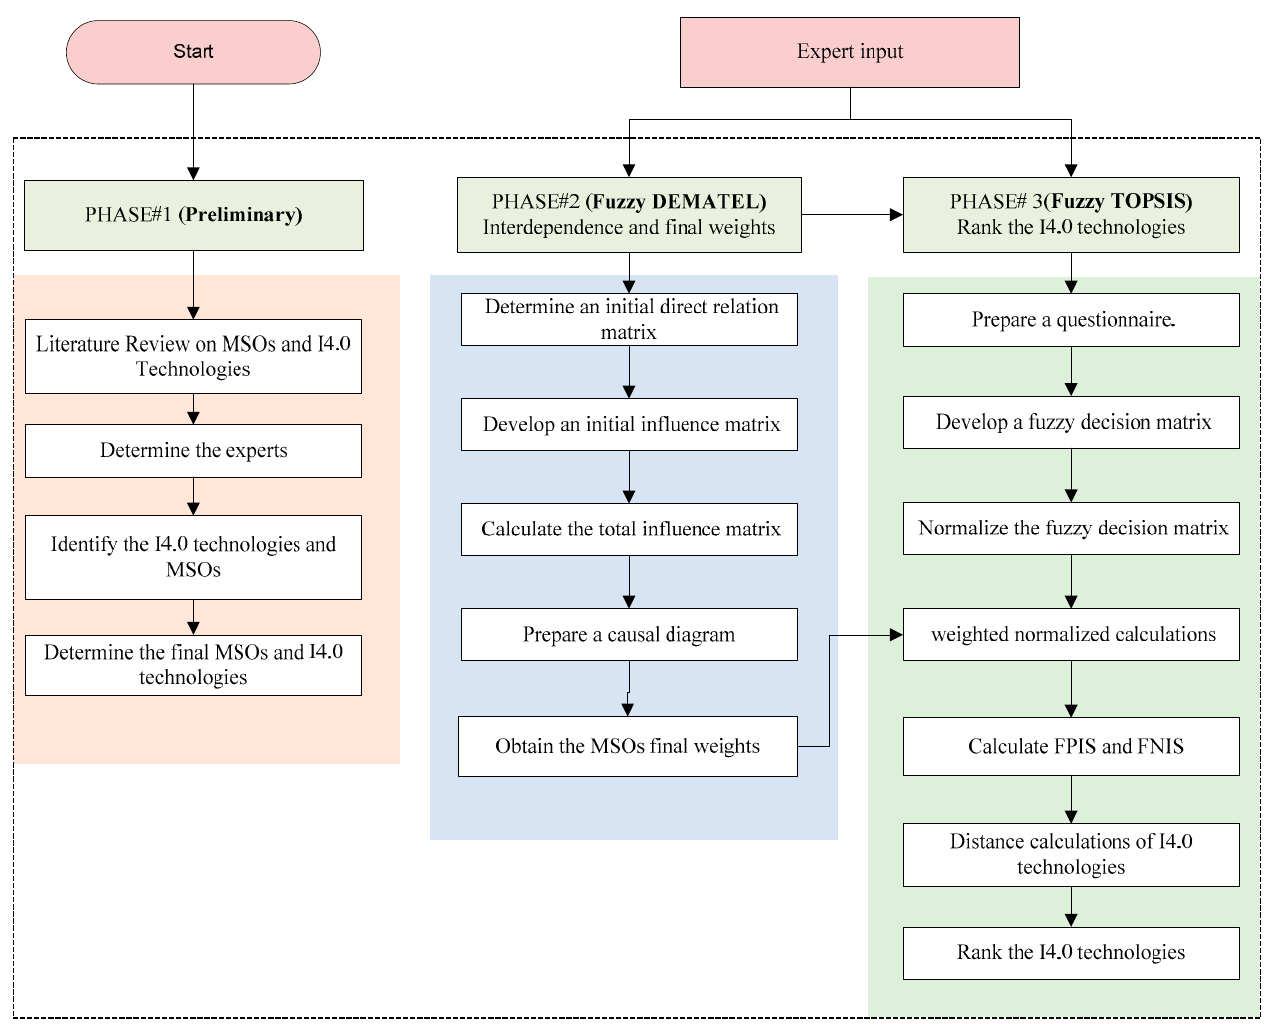
Figure 4. A hybrid MCDM evaluation model.